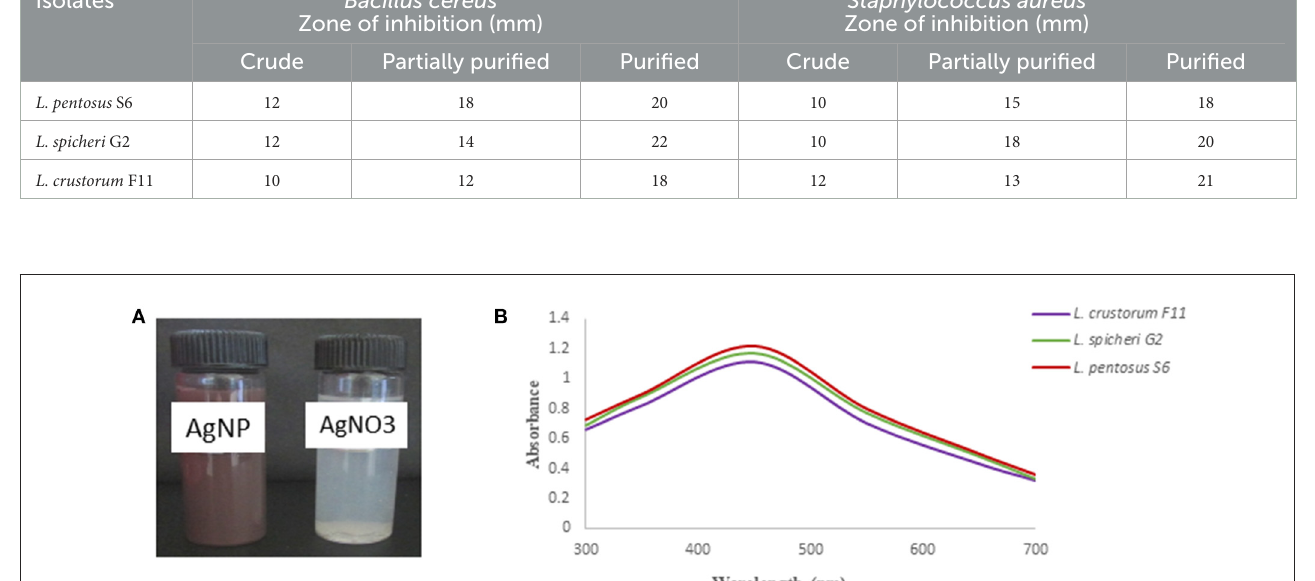
TABLE 1 Antimicrobial activity of crude, partially purified and purified bacteriocin against different pathogens of selected probiotics. Isolates